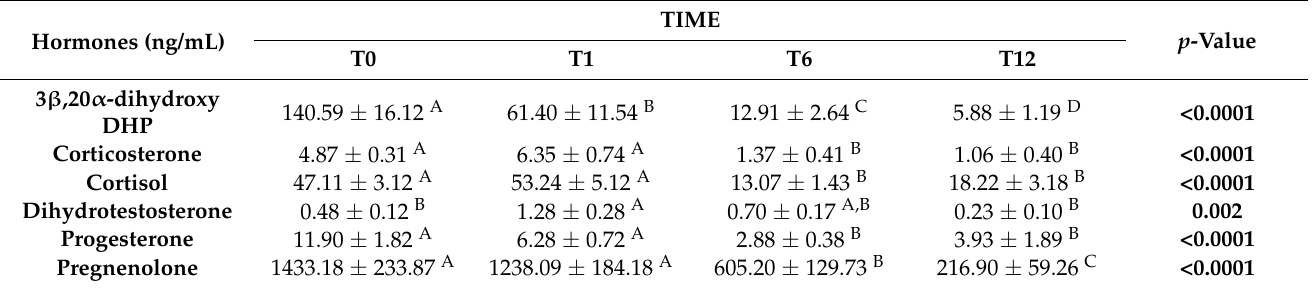
A,B,C,D : Different letters on each row indicate statistical difference ( p ≤ 0.05) between treatments. p -values are shown. Significance was set at p ≤ 0.05. The bold on the tables indicates the p -values that are smaller than